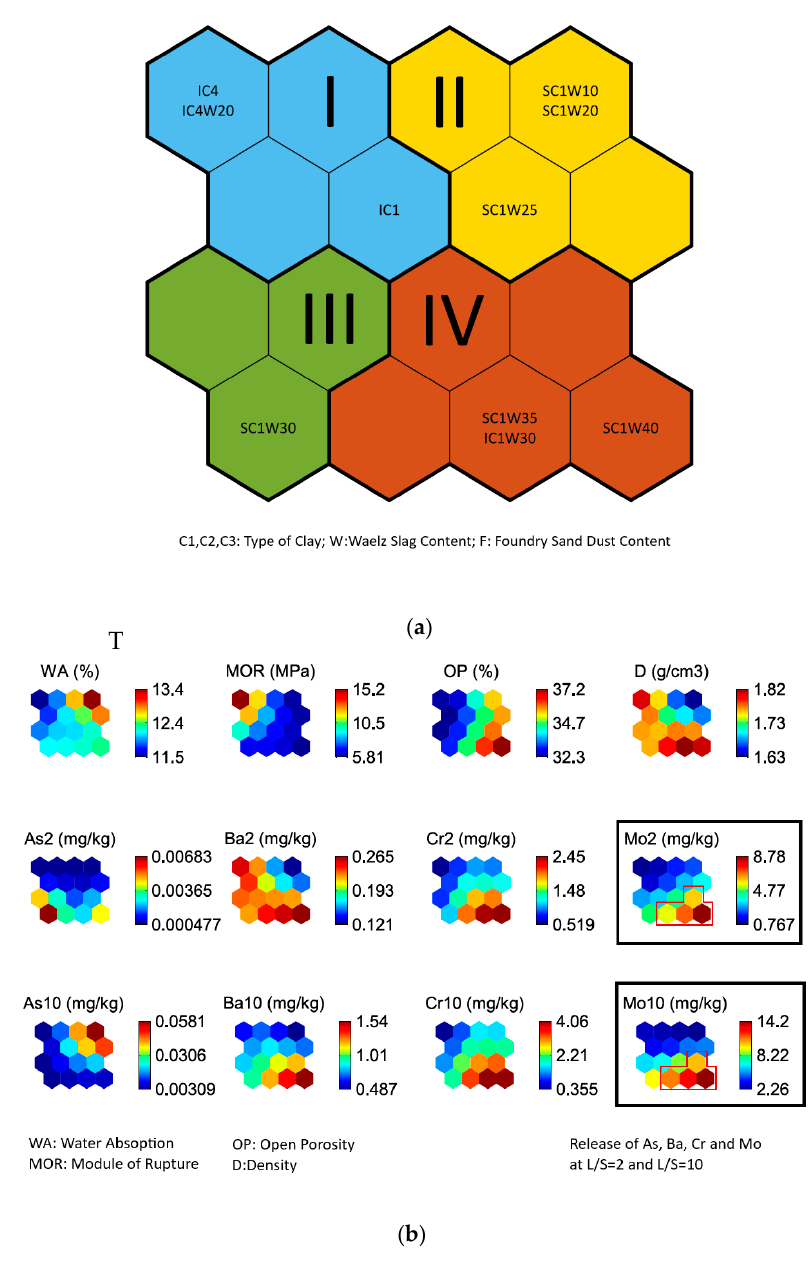
Figure 5. ( a ) Clustered map with labels of the studied pilot-plant and industrial clay mixtures with WS incorporation. The 4 clusters (I–IV) have been derived from the k-means algorithm applied to the trained SOM. The labels in the hexagons of the map show the BMU corresponding to each sample. ( b ) Component planes of the SOM for the 12 input variables with Mo highlighted along with neurons that exceed non-hazardous landfill limits. Each map corresponding to one variable (component) should be compared to the map representing the distribution of the pilot-plant and industrial clay mixtures with WS incorporation presented in Figure 5a; hexagons in the same place on different component planes correspond to the same map unit. The colours indicate the value of the component in the weight vector of each unit of the map, according to the colour bars on the right.